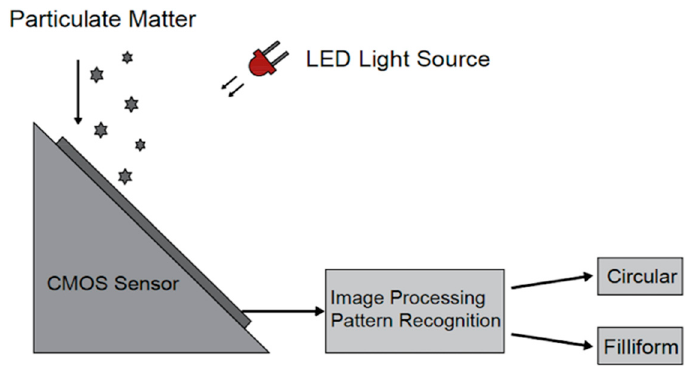
Figure 12. Dust sensor setup based on deposition on the CMOS camera.